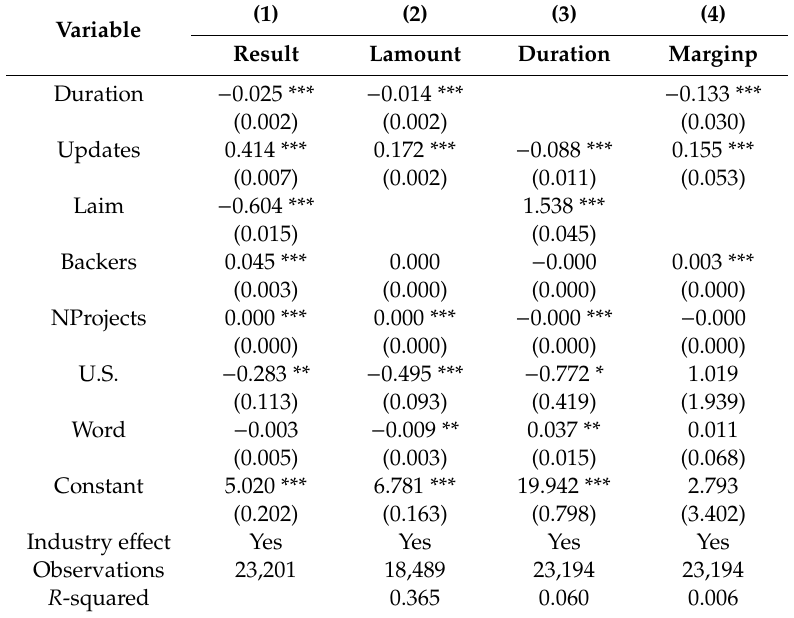
Table 7. Results for the whole sample. This table reports results of regression analysis of the success, amount raised, duration, and margin (%) for the complete sample. We controlled for di ff erent variables. Table 3 defines all the